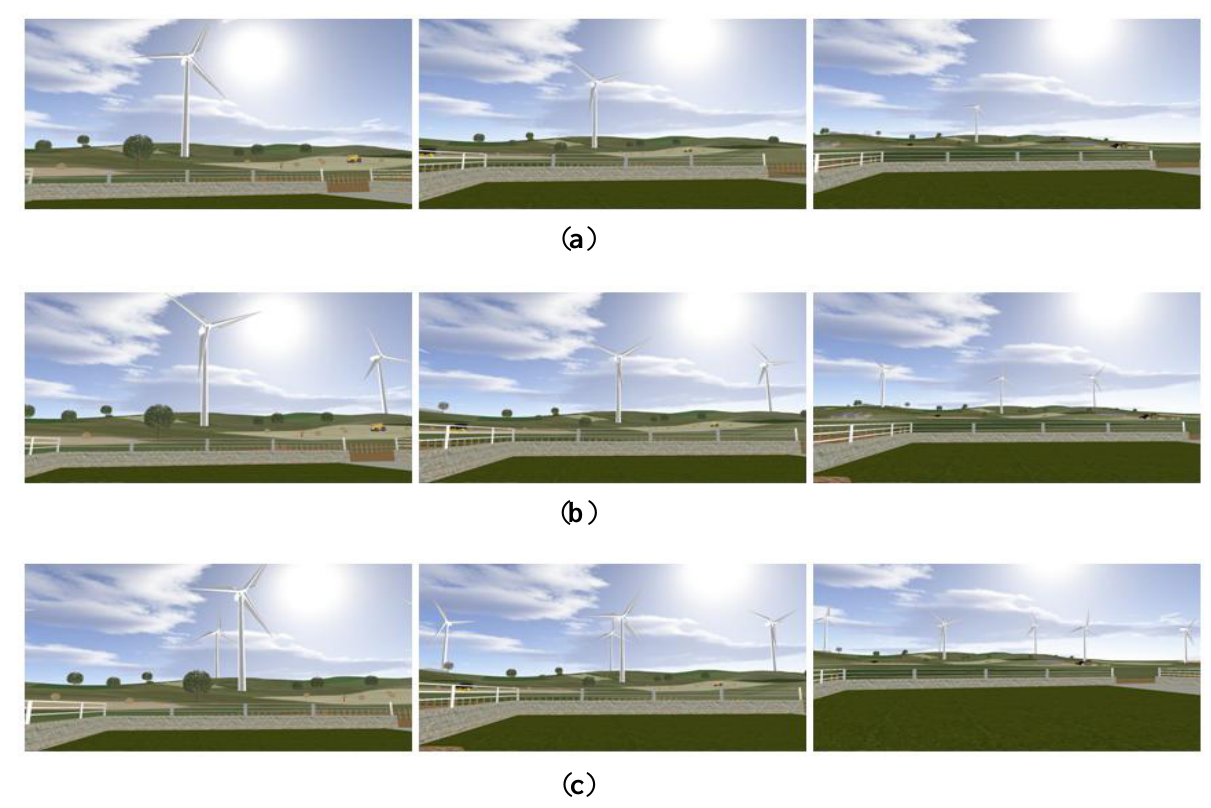
Figure 2. Frames of the scenarios at the distance of 150, 250 and 500 m with one turbine ( a ), three turbines ( b ) and six turbines ( c